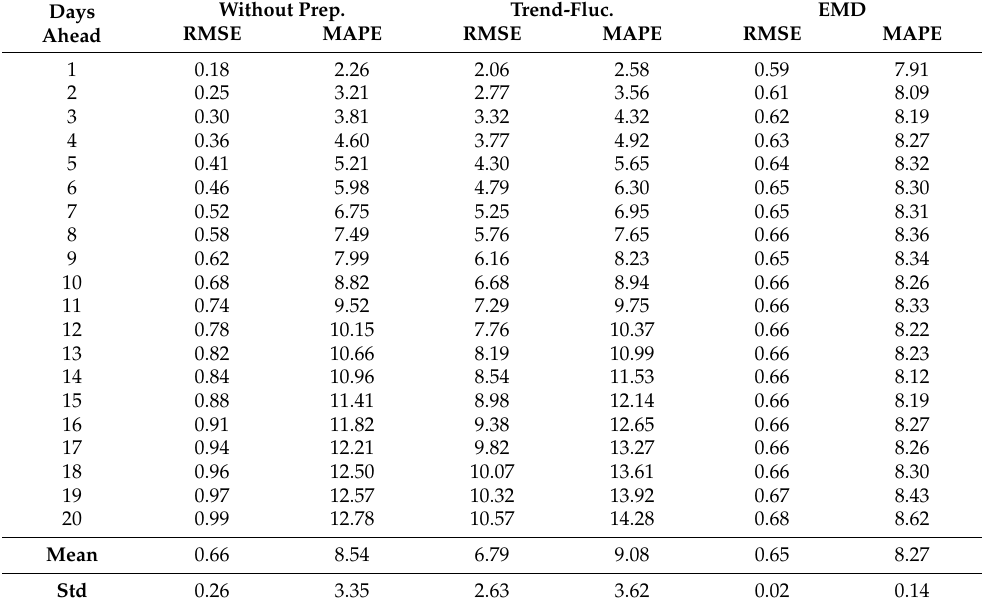
Table 7. Predictions with XGBoost for the reduced data set (2009–2016). 60% of them were used for training and 40% for validation. Data have been scaled with standardization for “Without Prep.” and “Trend-Fluc.” and with Min-Max for EMD. Without Prep. Trend-Fluc. EMD Days RMSE MAPE RMSE MAPE Ahead